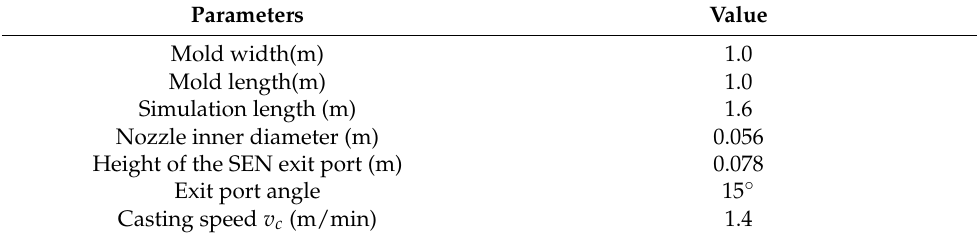
Figure 1. Refined area of the model mesh. Table 1. Casting parameter.